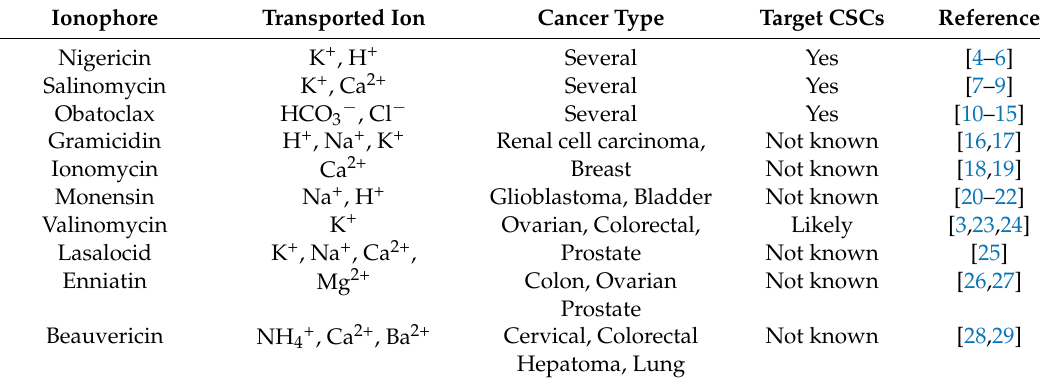
Table 1. Ionophores with anticancer